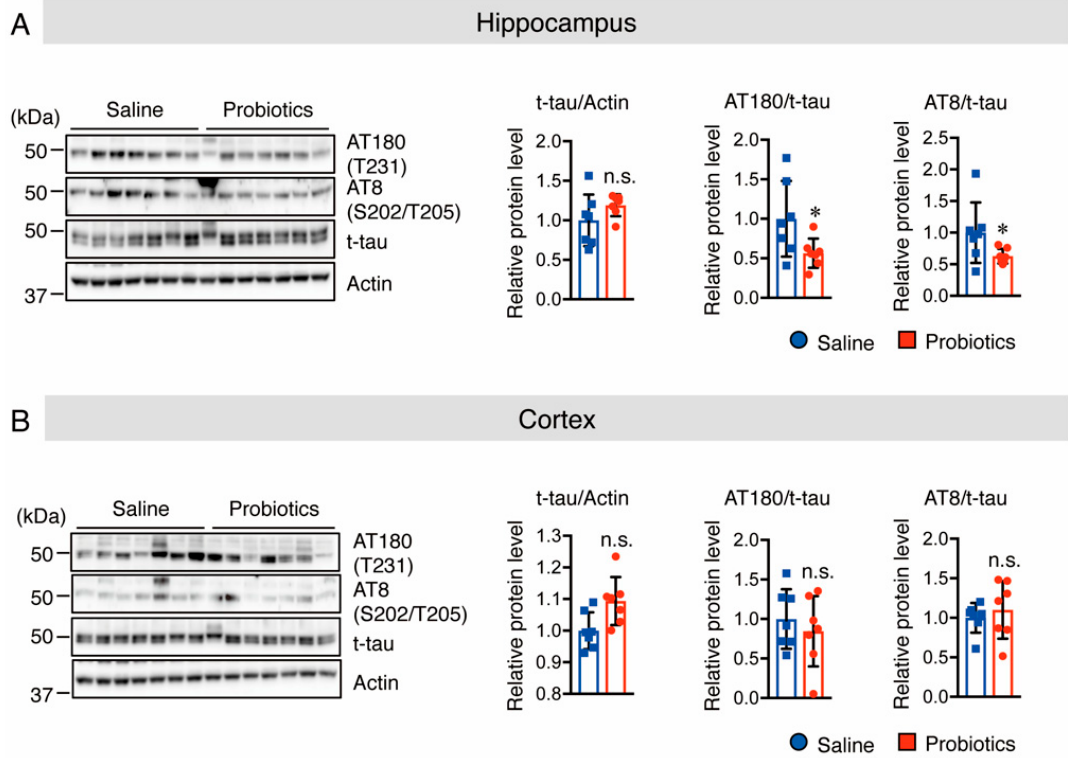
Figure 5. Oral supplementation of B. breve MCC1274 inhibits tau phosphorylation in the hippocampus of WT mice. Western blot analysis of tau phosphorylation at site T231 (AT180), S202/T205 (AT8), total tau, and actin in the hippocampus ( A ) and cortex ( B ). Quantification of phosphorylated (p-) protein levels normalized to total (t-) protein levels and expressed as values relative to the control. Data are represented as mean ± SD; n = 7 per group; n.s. no significant difference; * p < 0.05 compared with the saline group, as determined by Student’s t -test.